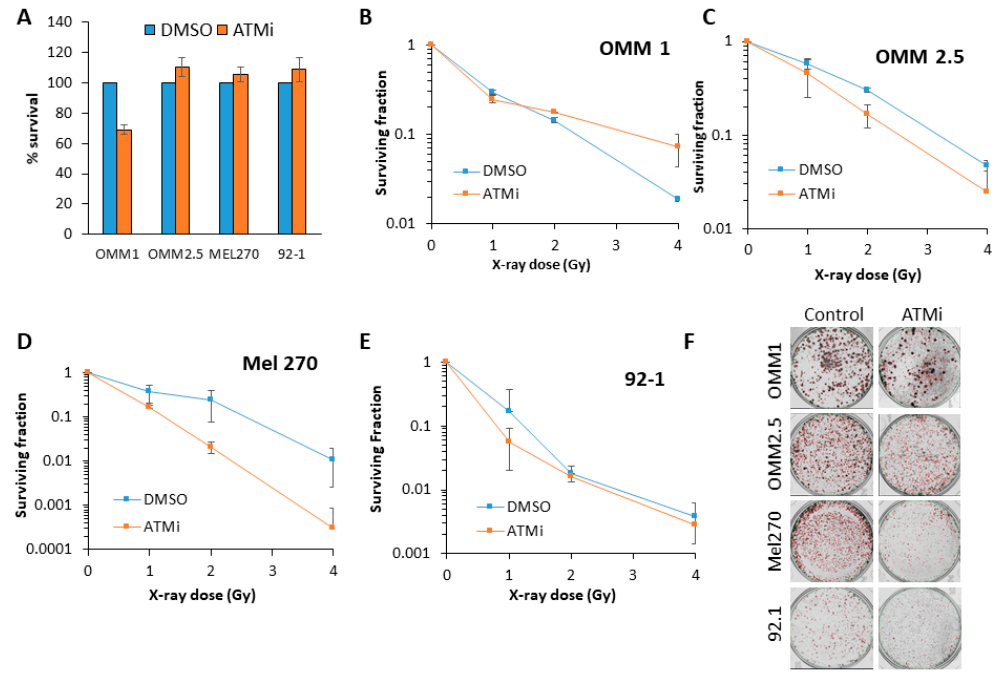
Figure 3. Comparative radiosensitivity of UM cells in the presence of ATM inhibition, following X-ray irradiation. The clonogenic survival of UM cells with (A) ATM inhibitor alone, or (B–F) following treatment with increasing doses of X-rays was analyzed from three independent experiments. (B–E) Shown is the surviving fraction ± S.E. (F) Representative images of colonies in non-irradiated and irradiated (2 Gy) plates (the latter were seeded with double the number of cells, accordingly).